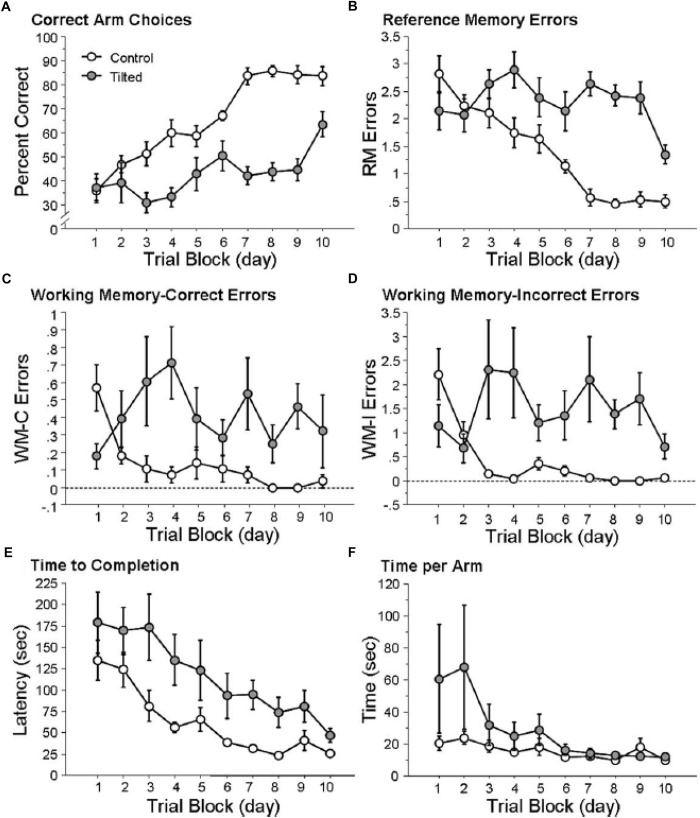
Tilted mice were impaired at place learning on the radial arm maze. (A) Percentage of correct arm choices increased more rapidly across trial blocks for control mice than for tilted mice. (B–D) RM, WM-C, and WM-I errors decreased across trial blocks for control mice but not for tilted mice. (E) Latency to complete the task decreased across trial blocks for both groups. (F) Time per arm did not differ between control and tilted mice. Mean ± SEM. Reproduced from Yoder and Kirby (2014) with permission.